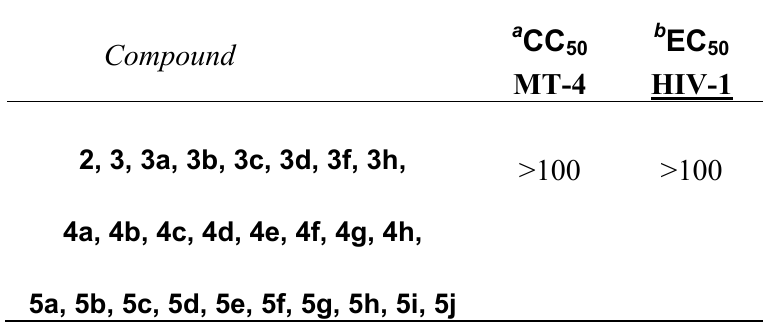
Table 1. Cytotoxicity and anti-HIV activity of compounds 2 − 5j